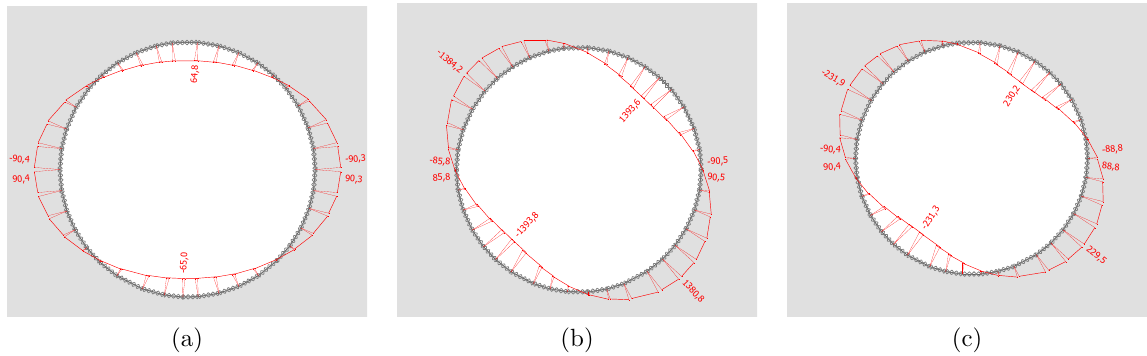
Figure 10. Distribution of moments: a) at the end of excavation step, b) at the end of pseudostatic analysis - fixed boundary, c) at the end of pseudostatic analysis - absorbing boundary.